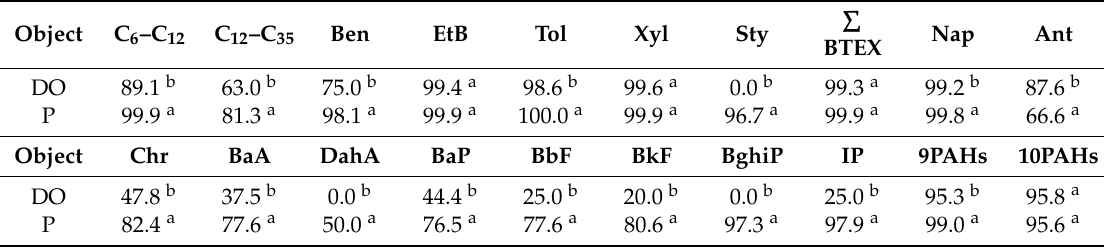
Table 3. Degradation of hydrocarbons in soil contaminated with diesel oil (DO) and unleaded petroleum (P). %.